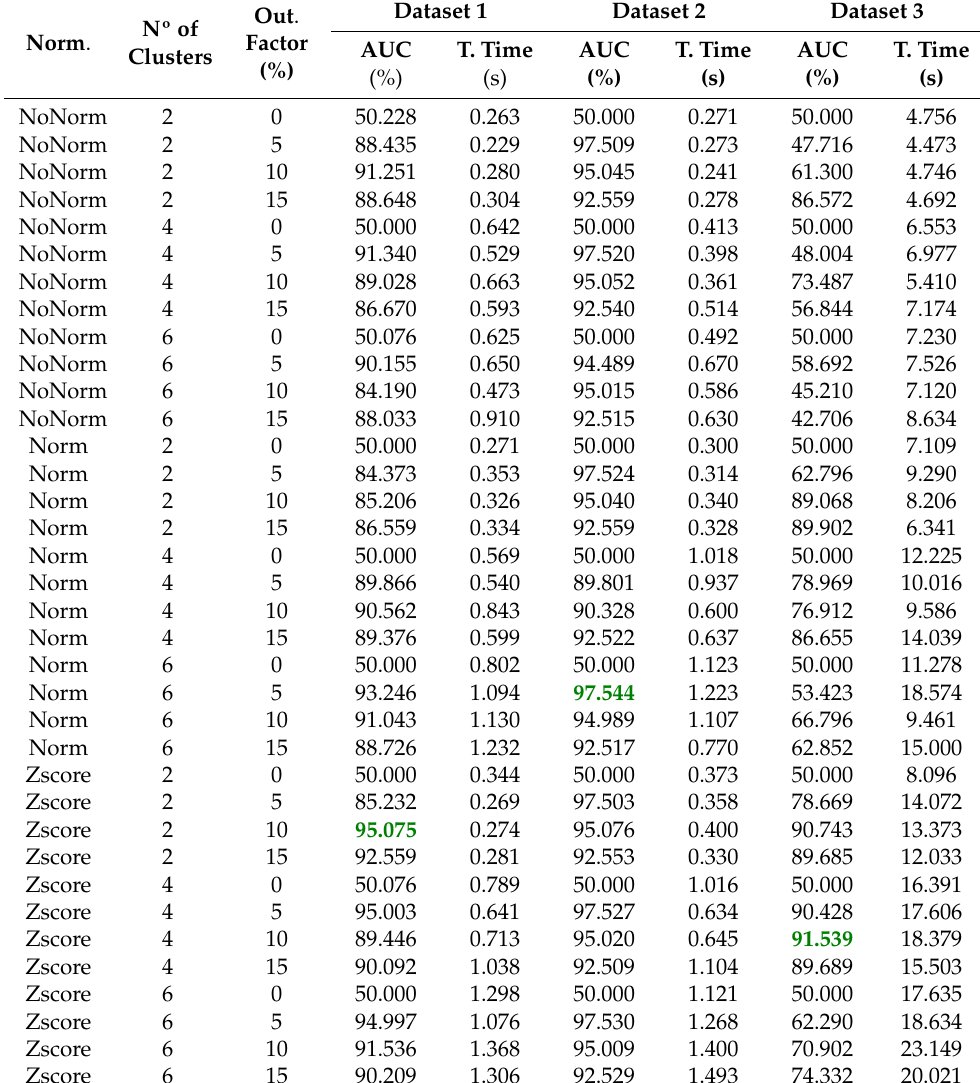
Table 3. K-means